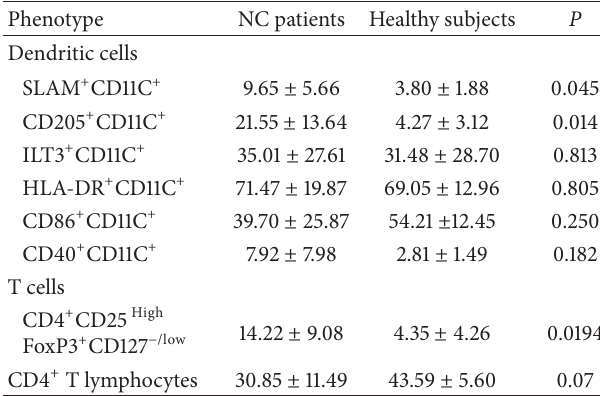
Table 2: Phenotype of peripheral dendritic and regulatory T cells in NC patients and healthy